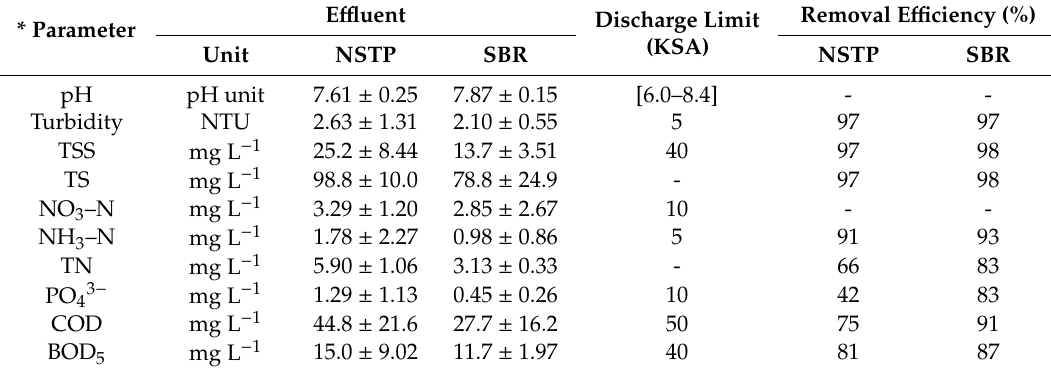
Table 5. Comparison of NSTP and SBR e ffl uents and their